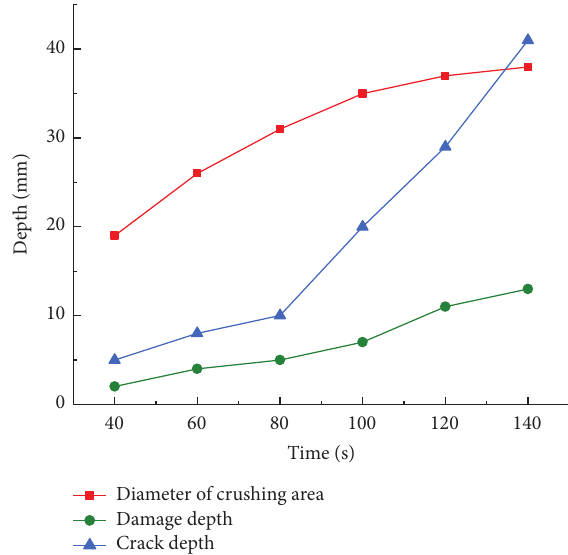
Figure 9: The change of different failure parameters with